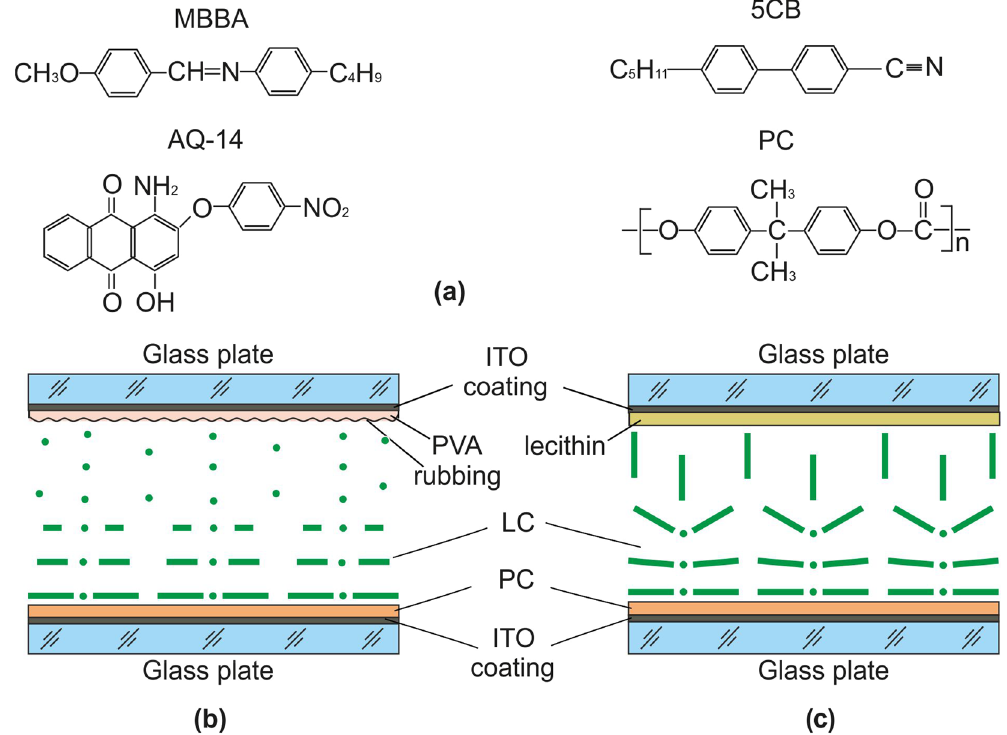
Figure 1. Schematics and arrangement of the materials in cells. ( a ) Chemical structures of the MBBA and 5CB nematics, AQ-14 dye, and polycarbonate (PC). Geometries of ( b ) cell A and ( c ) cell